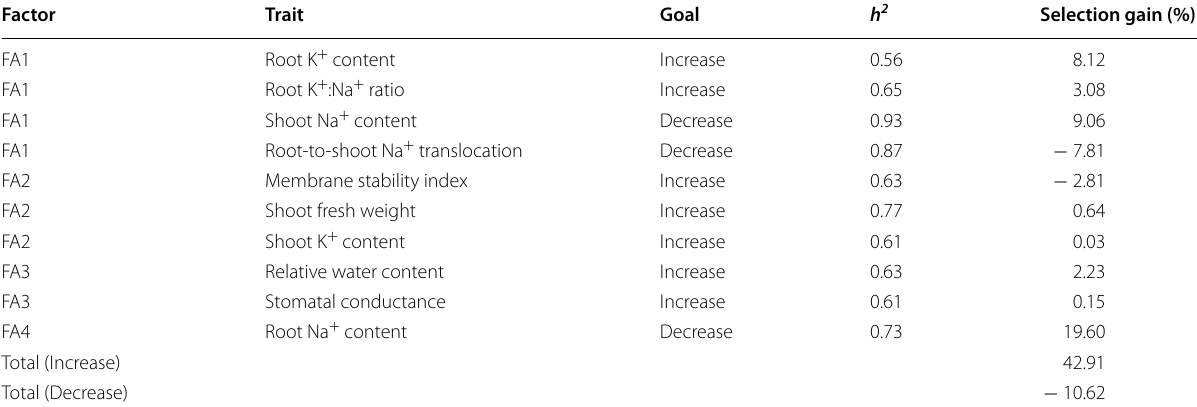
Table 2 Predicted genetic gain for the effective traits in the MGIDI index under salinity stress conditions Factor Trait Goal h 2